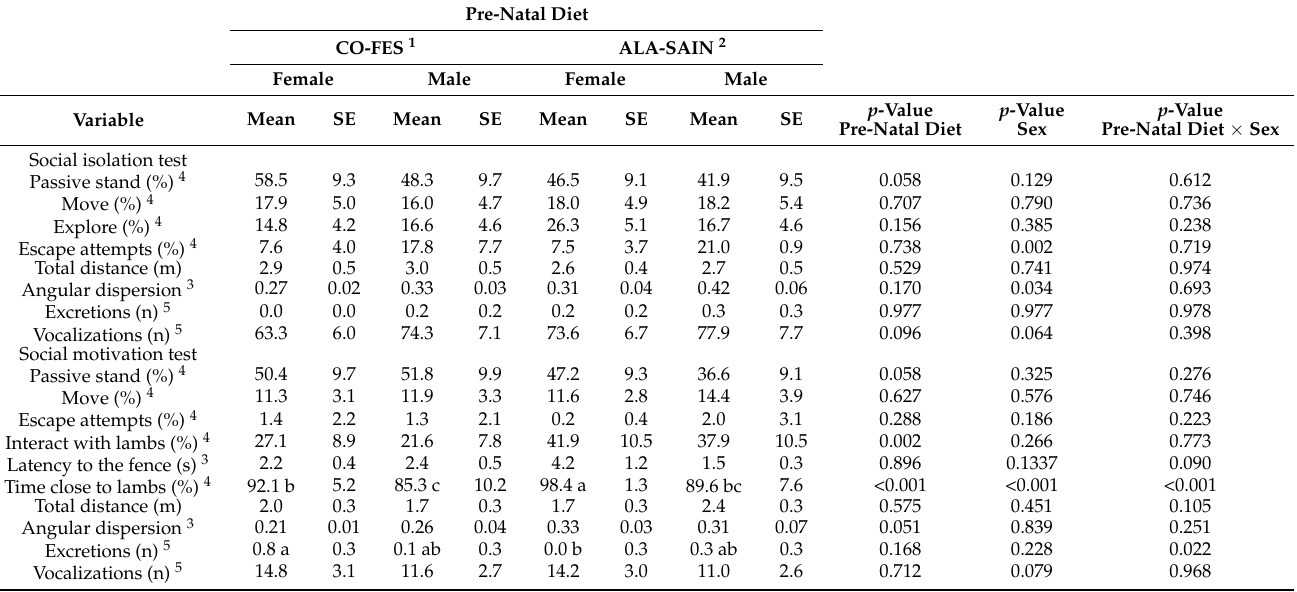
Table 5. Effects of pre-natal diet, lamb sex and their interaction on the behavior of lambs during the social isolation and social motivation tests. Pre-Natal Diet CO-FES 1 ALA-SAIN